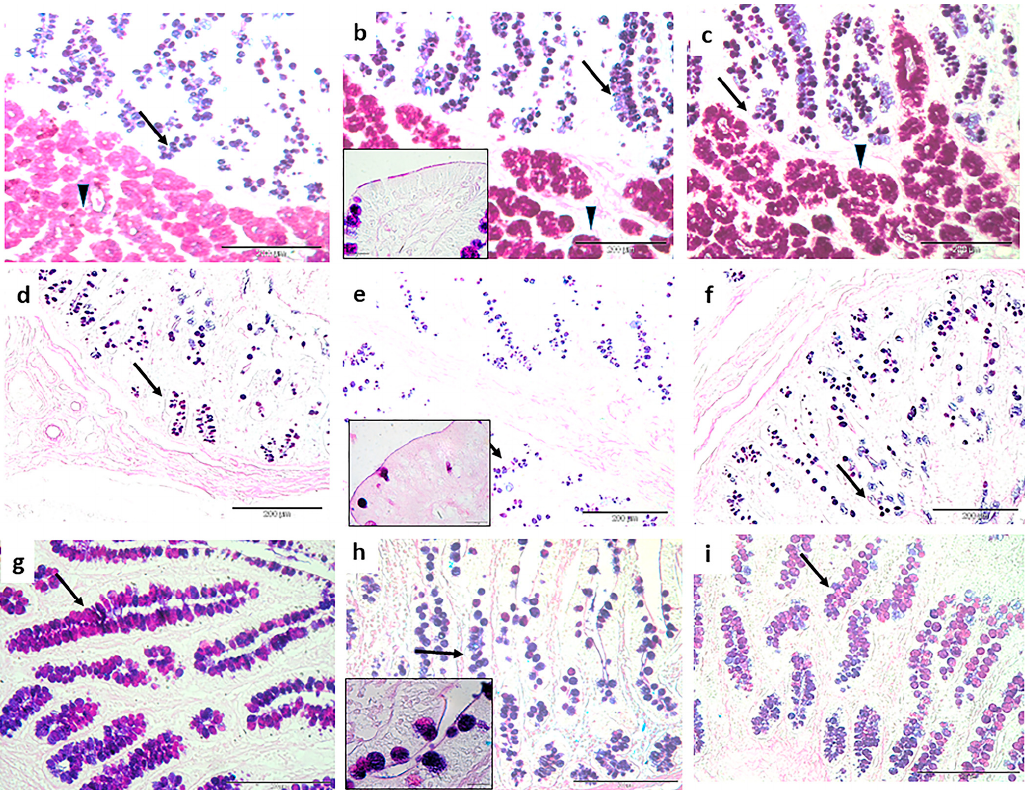
Figure 2. Histochemical findings of sections of the small intestine (Alcian blue 8GX, pH 2.5 ‐ periodic acid ‐ Schiff combination (AB ‐ PAS) staining) in each group: ( a ) duodenum, CTR; ( b ) duodenum, T1; ( c ) duodenum, T2; ( d ) jejunum, CTR; ( e ) jejunum, T1; ( f ) jejunum, T2, ( g ) ileum, CTR; ( h ) ileum, T1; and ( i ) ileum, T2. The arrows indicate intestinal goblet cells; the arrowheads indicate Brunner’s glands; the blue color indicates acidic mucins; and the pink color indicates neutral mucins. The inserts ( b , e , h ) are representative images at a high magnification (100 ×) of the mucosal layer.